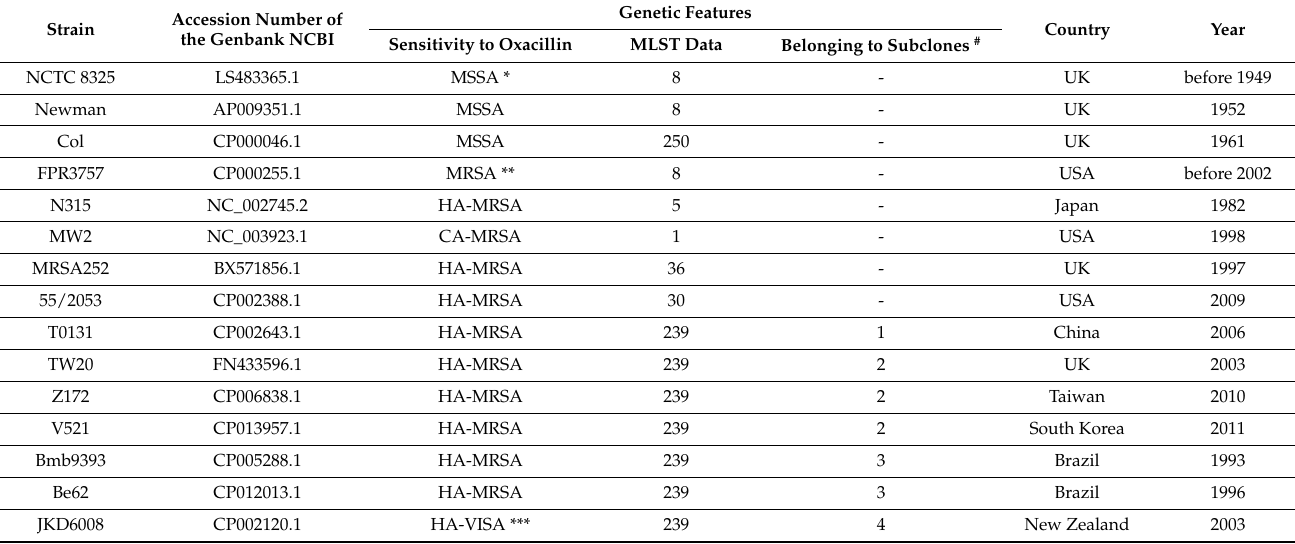
Table 1. Staphylococcus aureus